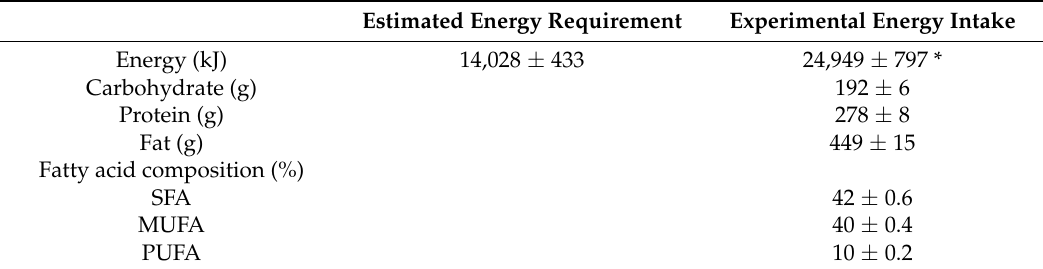
Table 1. Energy and nutrient